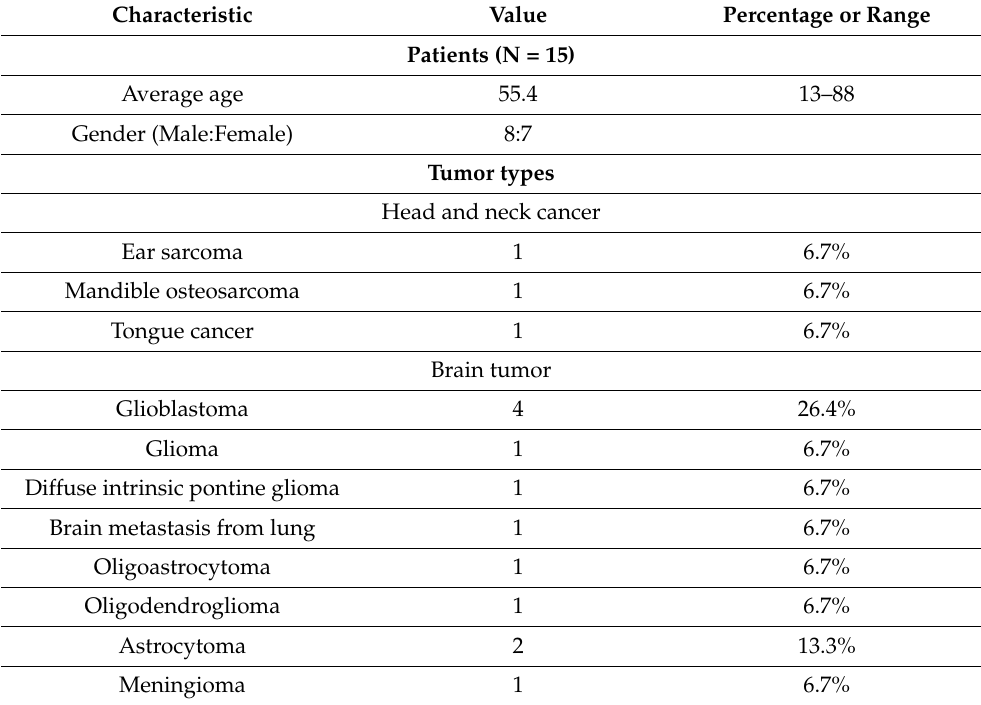
Table 1. Clinical characteristics of study